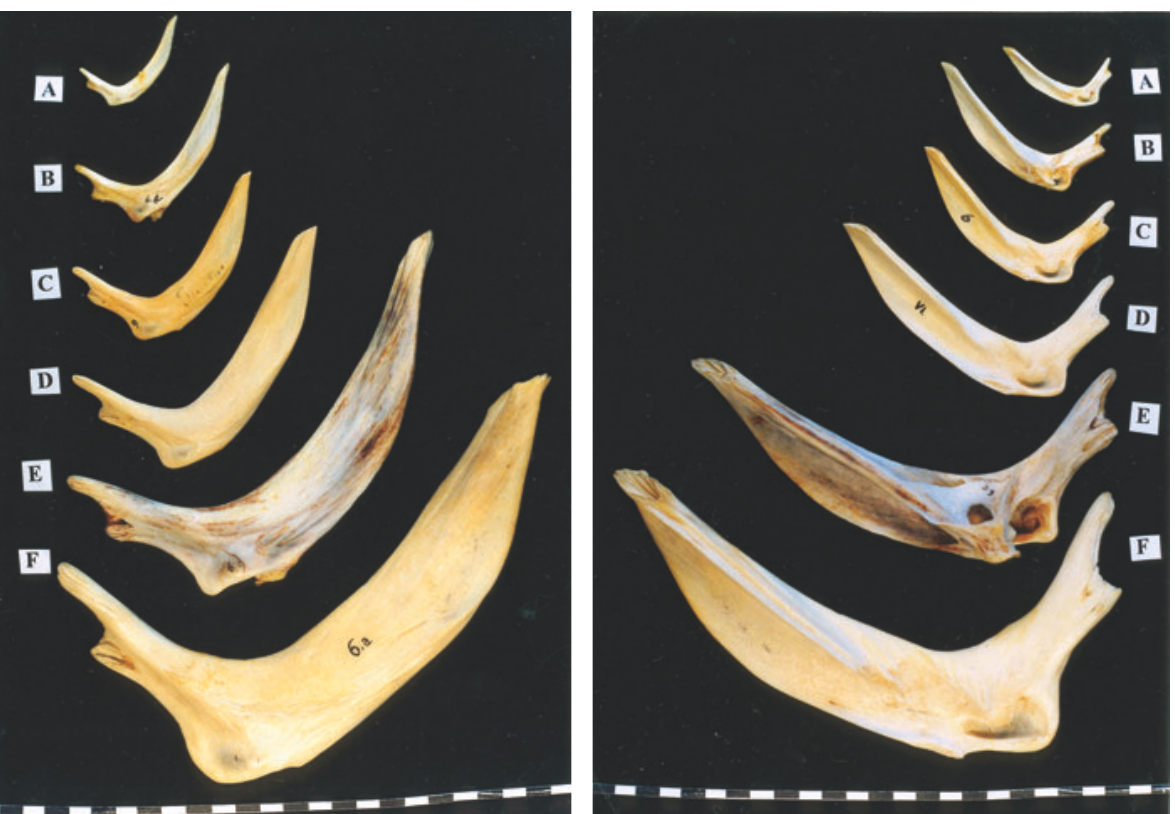
Fig. 1. Comparative materials: left cleithrum bones of the European wels catfish, Silurus glanis L., individuals weighing: A, 0.40 kg; B, 1.19 kg; C, 2.57 kg; D, 5.10 kg; E, 21.10 kg; F, 32.30 kg (outer- and inner view)